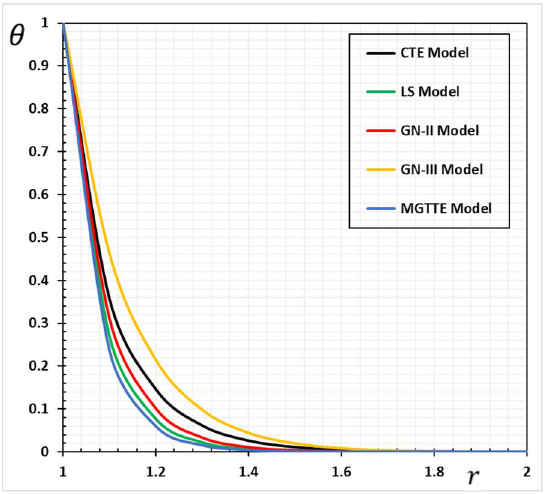
Figure 9. The temperature change, θ , versus different thermoelastic models.